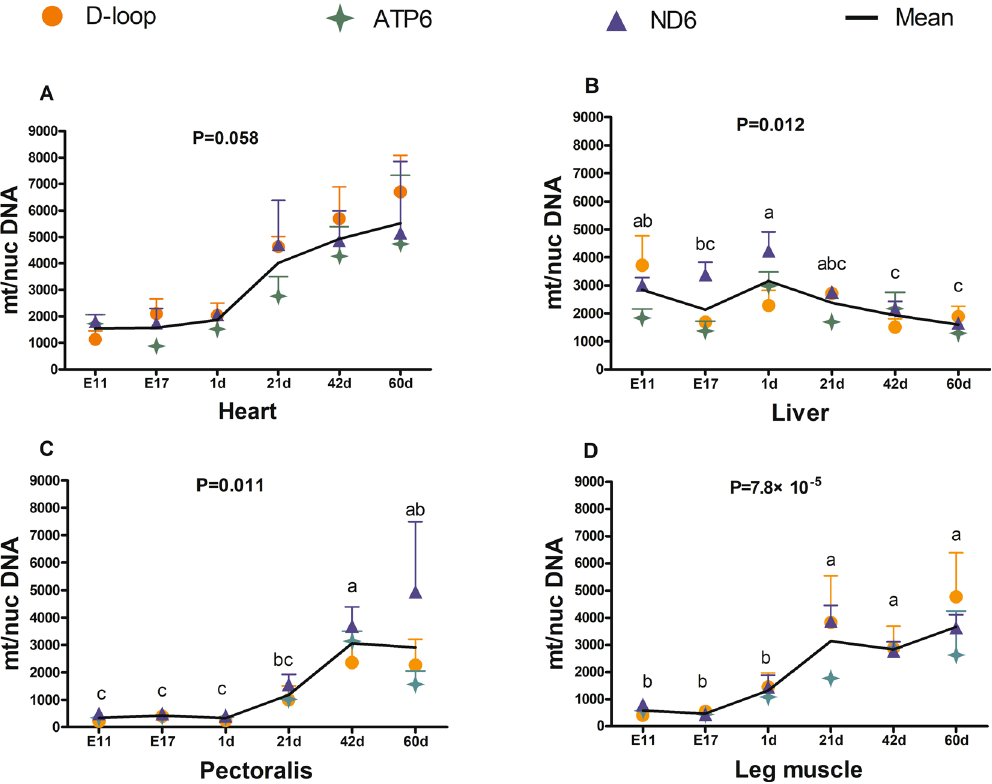
Figure 2. Change in mtDNA copy number with age in different tissues from broilers. ( A ) Heart; ( B ) liver; ( C ) pectoralis; ( D ) leg muscle. mt/nucDNA = mtDNA relative to nuclear DNA ( GCG ) copy number. Different letters indicate P < 0.05, and the same or no letter indicates P > 0.05. n =